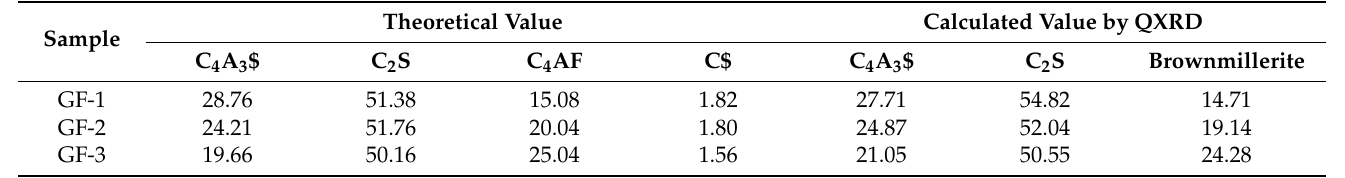
Figure 2. The QXRD patterns of the BBSC clinkers. Table 5. The main mineral compositions of the BBSC clinkers from the QXRD results (wt%).